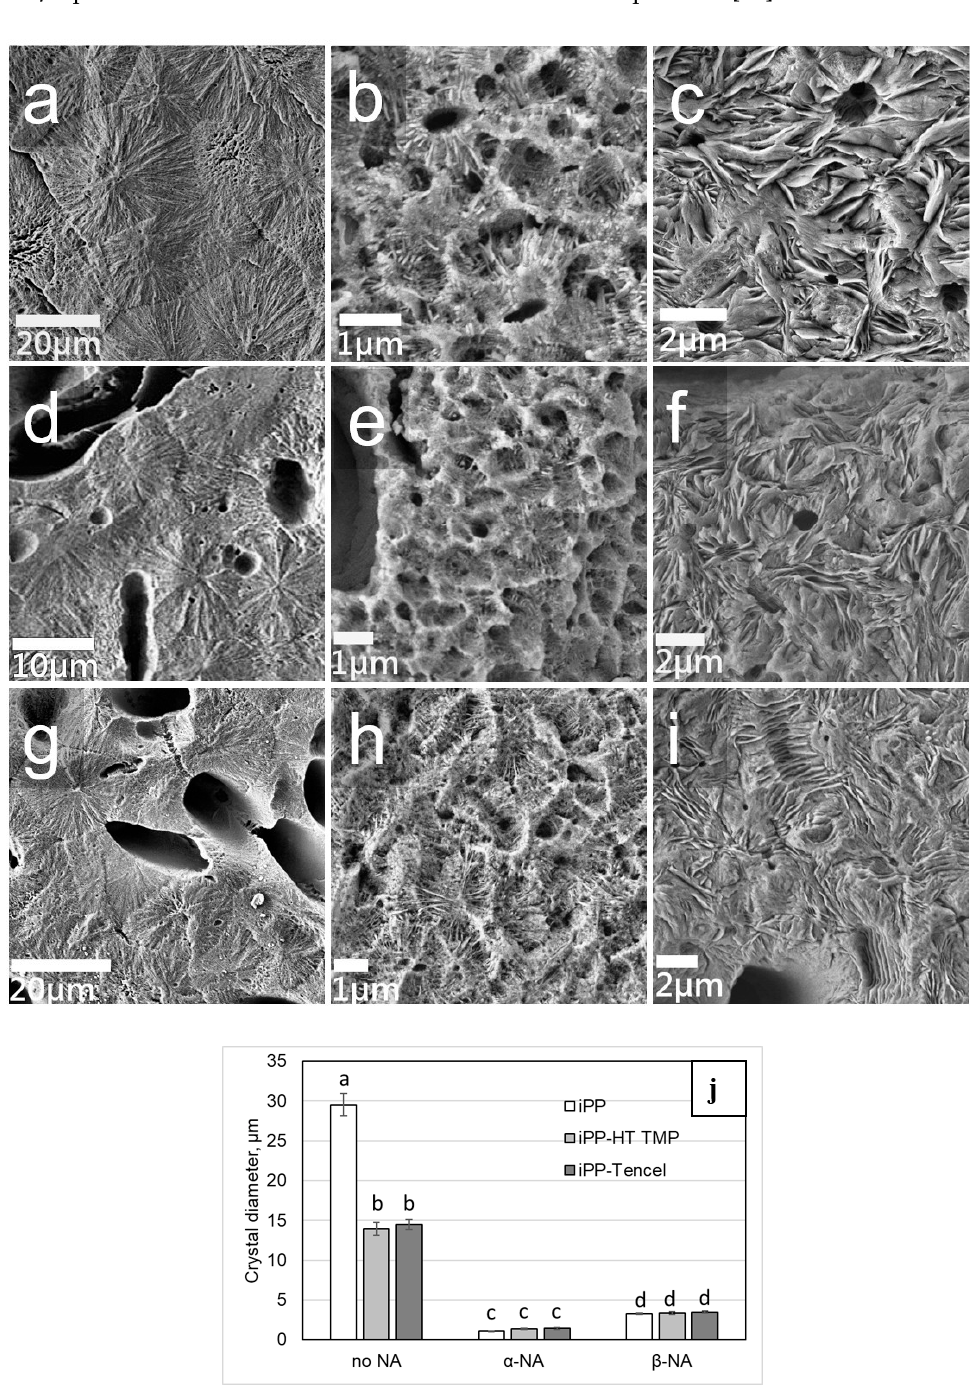
Figure 2. Scanning electron microscopy (SEM) images of iPP crystallisation. Transverse face of injection moulded samples after permanganate etching. ( a ) iPP, ( b ) iPP + α NA, ( c ) iPP + β -NA, ( d ) iPP + HT TMP, ( e ) iPP + HT TMP / α -NA, ( f ) iPP + HT TMP / β -NA, ( g ) iPP + Tencel ™ , ( h ) iPP + Tencel ™ / α -NA, ( i ) iPP + Tencel ™ + β -NA. ( j ) Crystal diameters of iPP and iPP composites with various NAs (n ~ 60, di ff erent letters indicate significant di ff erence at α = 0.05).